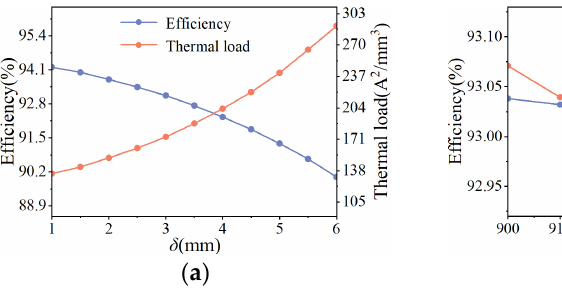
Figure 4. Influence curves of single factors on efficiency and thermal load. ( a ) Air gap length; ( b ) core length; ( c ) conductors per slot.